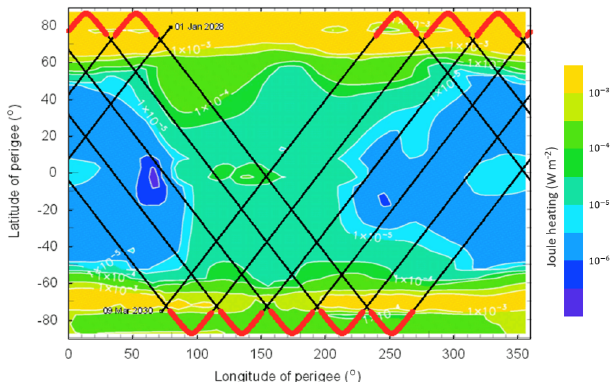
Figure 16. Perigee location history for nominal perigee altitudes of 150km are shown in black; perigee descents to lower altitudes of 120km are shown in red. In the background, a simulation of height- integrated Joule heating derived from the TIE-GCM is shown. Color indicates the height–integrated Joule heating (units: Wm − 2